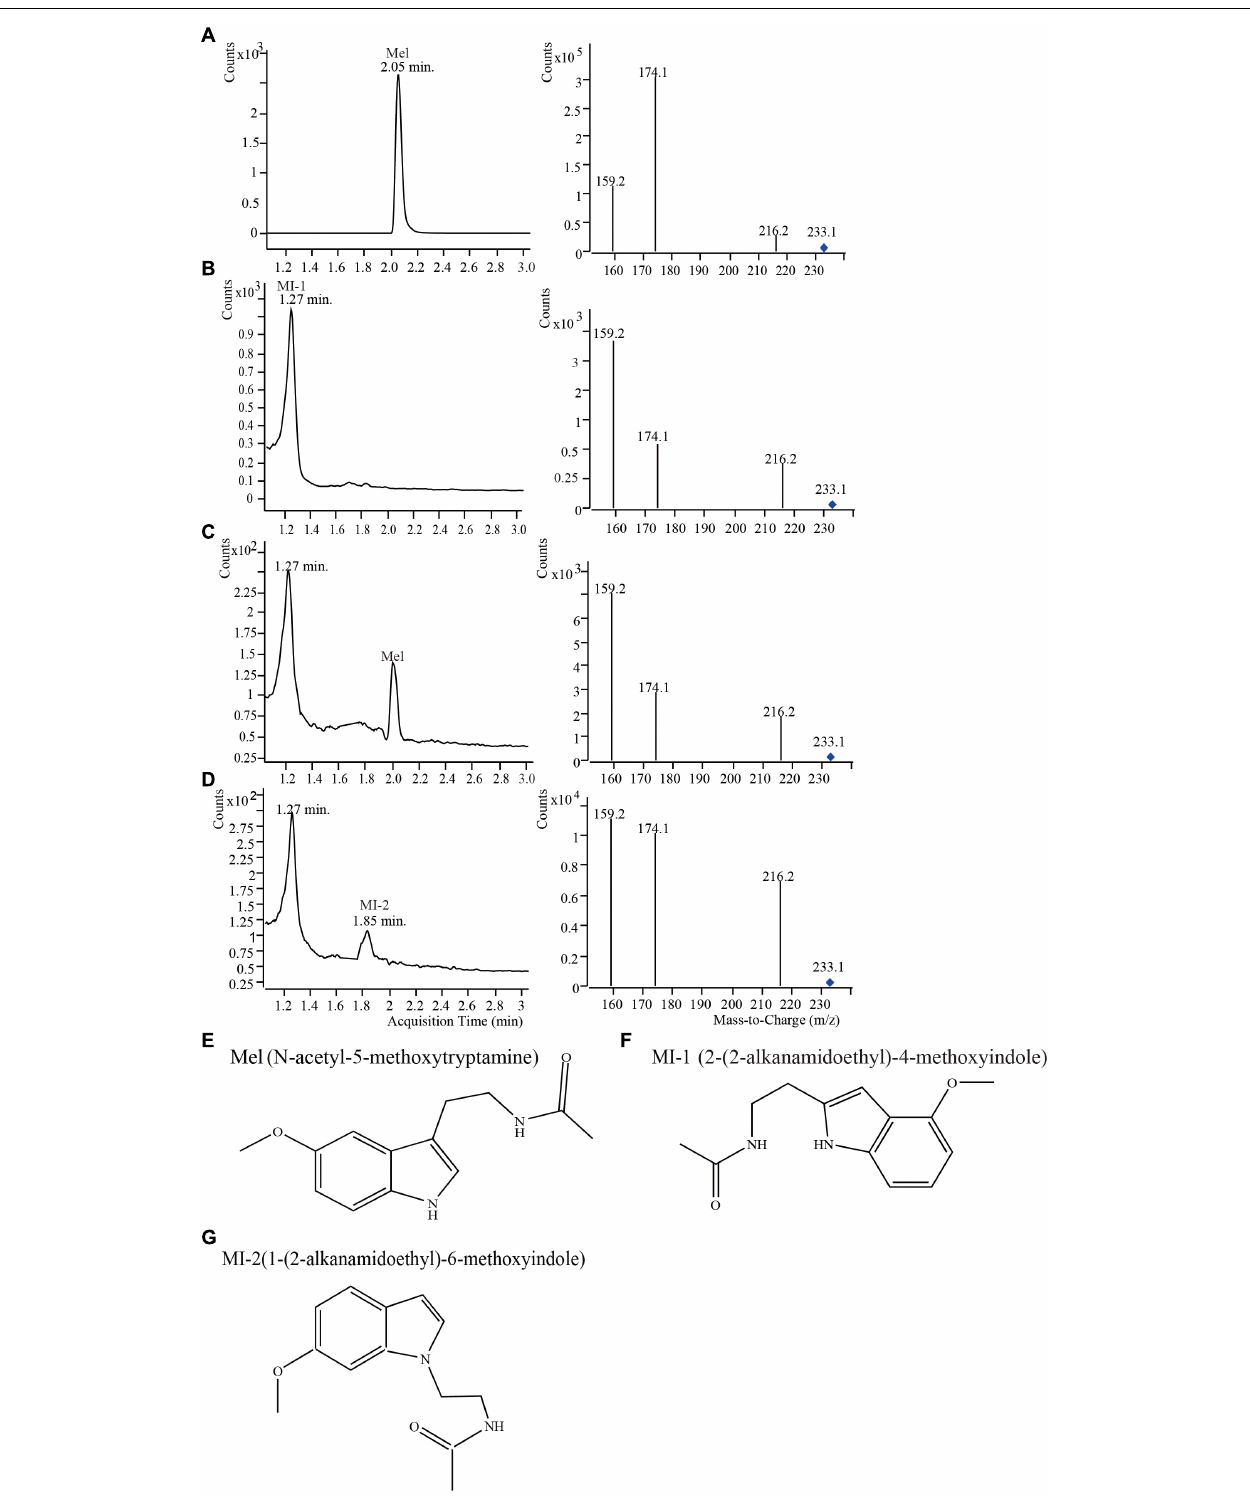
Frontiers in Plant Science |